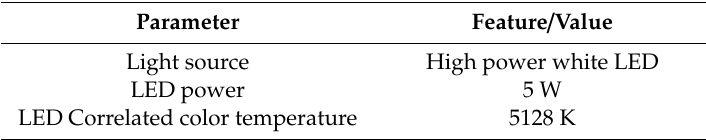
Table 4. Summary of the light source